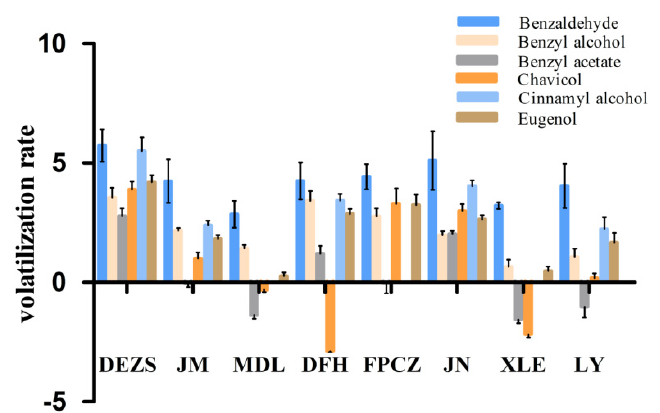
Figure 3. Volatilization rate of main compounds of P. mume cultivars with four aroma types. The vertical axis showed the natural logarithms (Ln) of the ratios of the endogenous extracts content to headspace volatiles content.